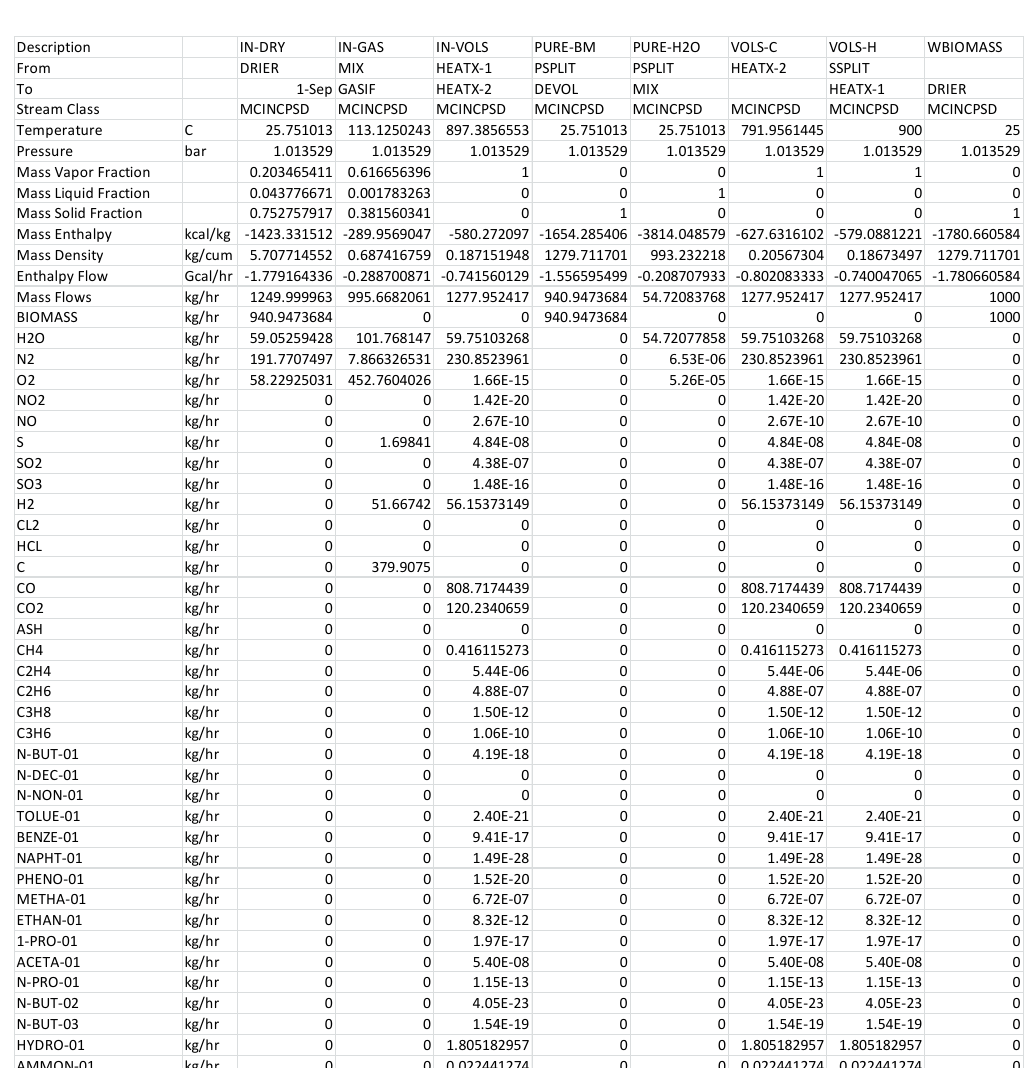
Figure A8. Gasification stream results (part 2).